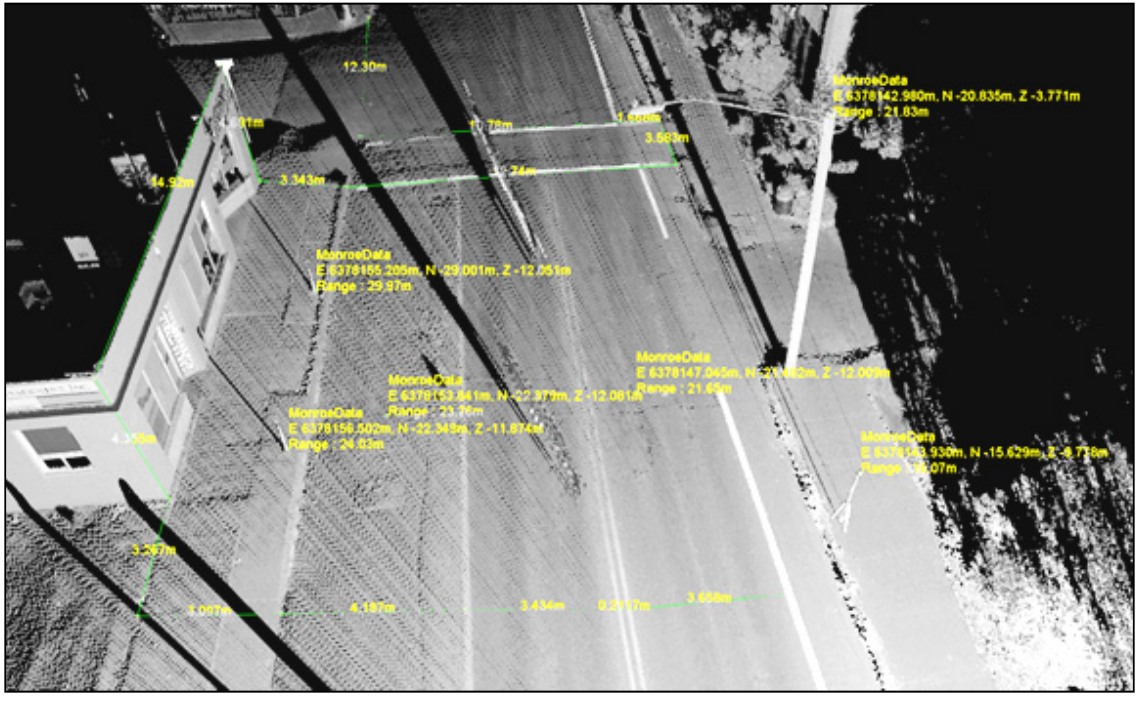
Figure 7. Linear measurements and point coordinates in a point cloud (static